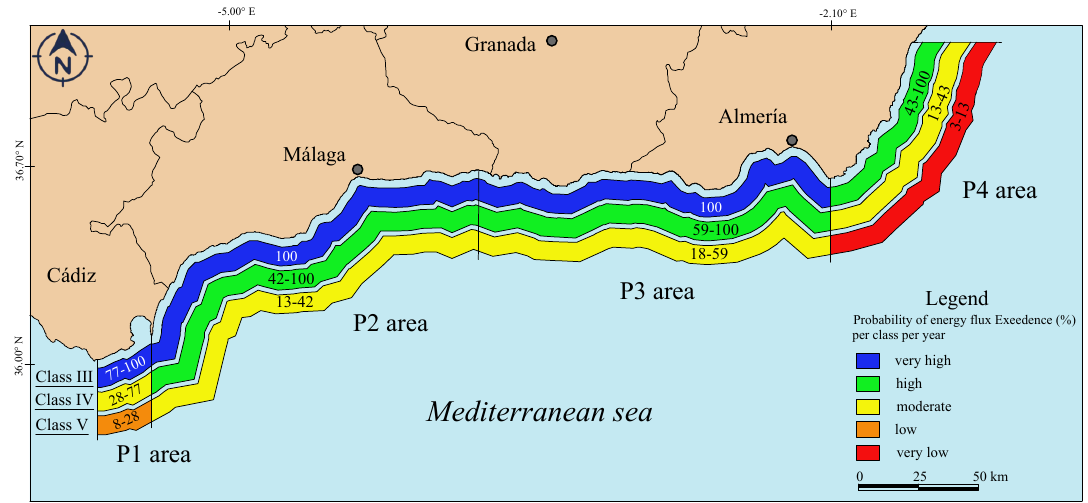
Figure 8. Energy flux probability of exceedance (%) of storms per class III, IV, and V at each point in the coastal area of influence. The percentage values per class as reported on Table 2 are superimposed in the colored